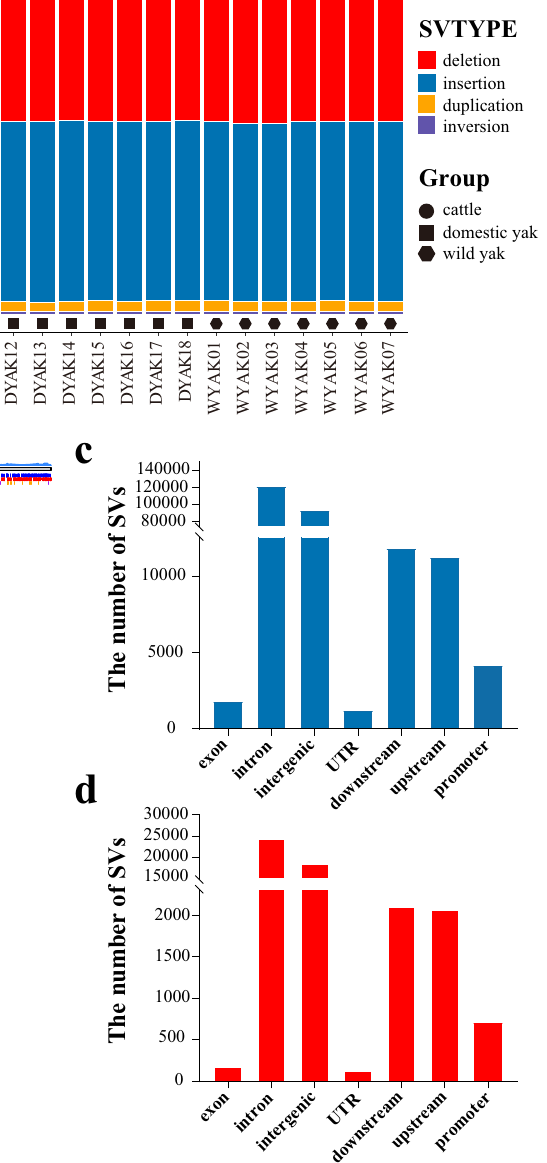
downsteam, upsteam, and promoter. d The histogram showing the number of SVs counted from the high-FST SVs located in exon, intron, intergenic, UTR, down- steam, upsteam, and promoter. Source data are provided as a Source Data fi